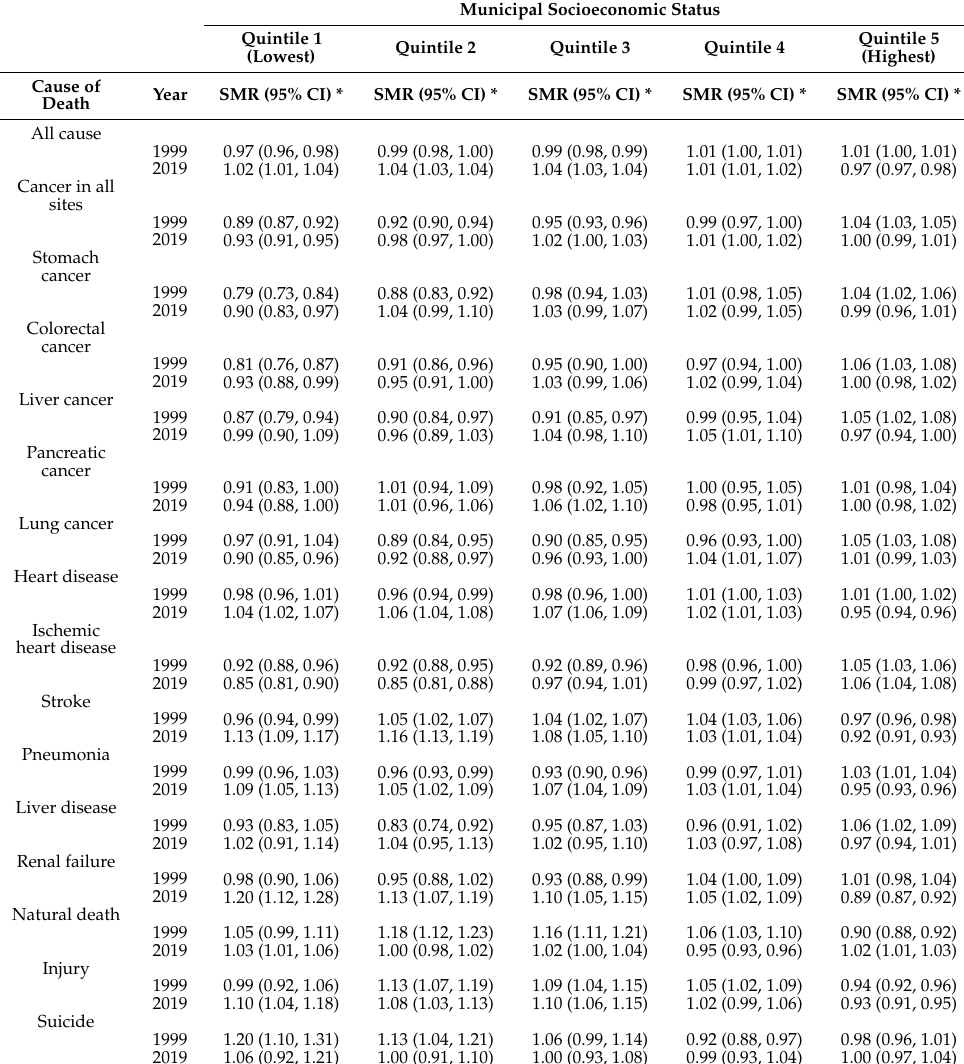
Table 4. SMR for all-cause and each cause of death by municipal SES quintile in 1999 and 2019 for